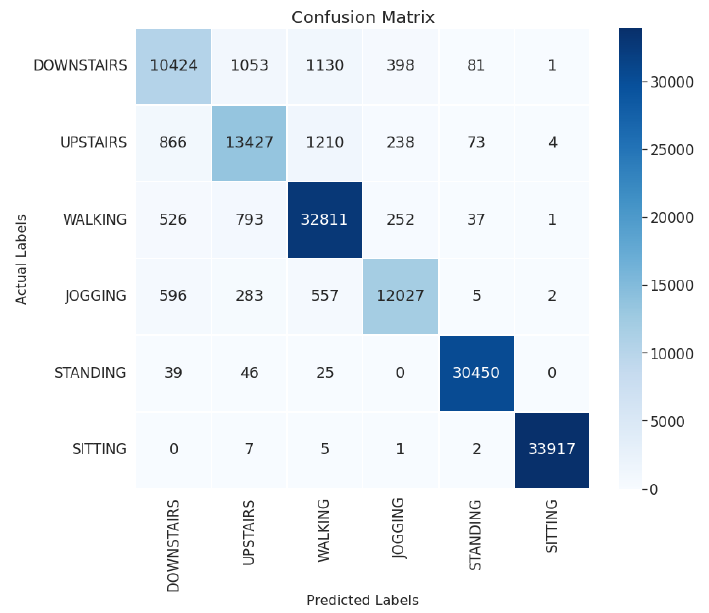
Figure 3. The confusion matrix of the 1D-CNN-BiLSTM model on the Motion Sense dataset.